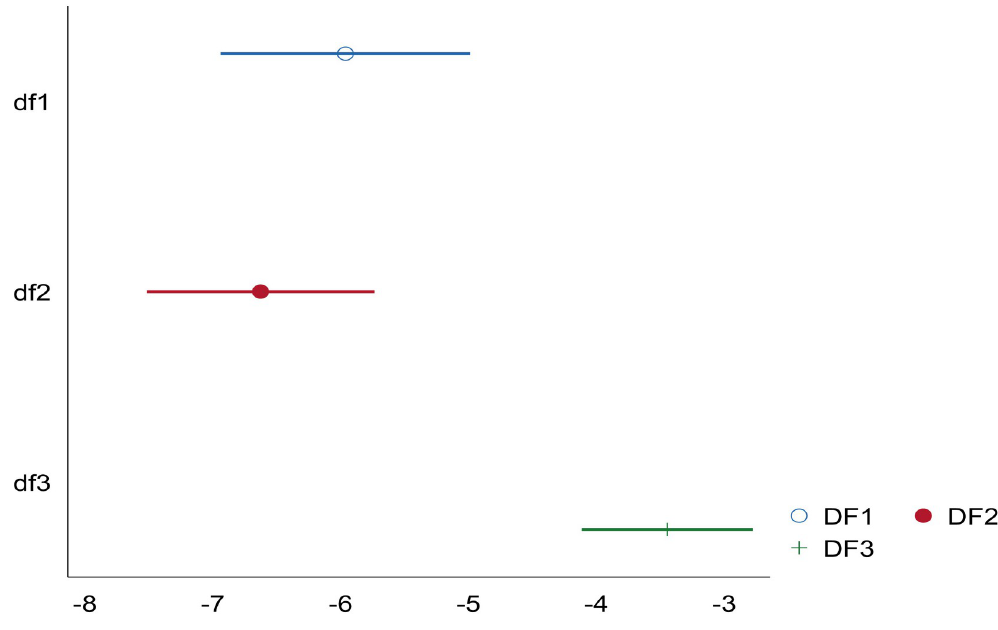
Fig 1. Marginal effects of df1, df2 and df3 on